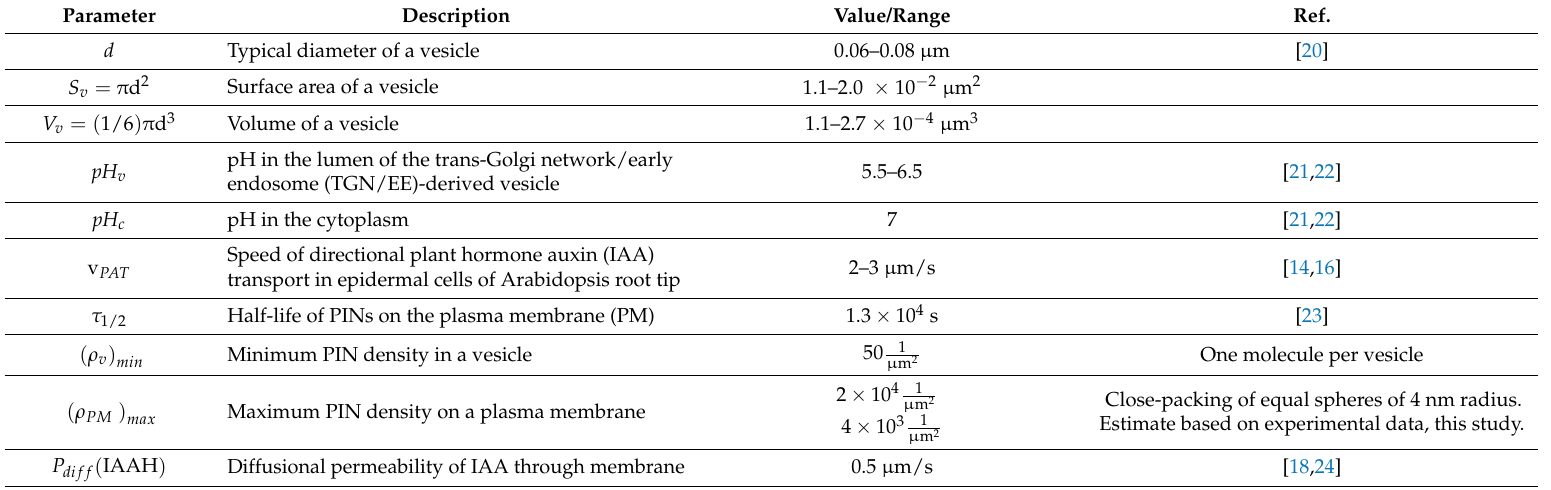
Table 1. Values of parameters used in this